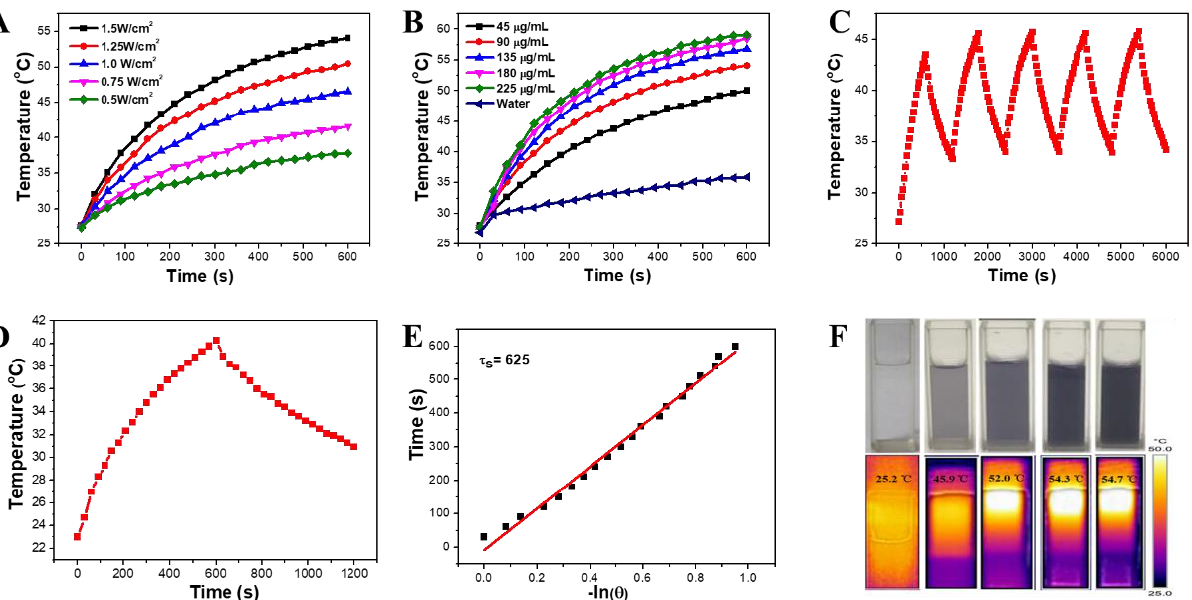
Figure 2. ( A ) Photothermal curves of PTA-NPs (45 µ g/mL) under irradiation of 635 nm laser at different power densities; ( B ) photothermal curves of PTA-NPs at different concentration under 635 nm laser irradiation (1.25 W/cm 2 ); ( C ) photothermal stability of PTA-NPs (45 µ g/mL) during five on/off cycles of laser (1.25 W/cm 2 ); ( D ) photothermal effect of PTA-NPs in water under irradiation of 635 nm laser (1.25 W/cm 2 ) for 10 min, followed by the cooling for 10 min; ( E ) negative logarithmic relationship between cooling time and temperature; ( F ) photothermal images of different concentrations of PTA-NPs under 635 nm laser (1.25 W/cm 2 ) irradiation (top: images of PTA-NP solution under natural light; bottom: thermal images after 635 nm laser irradiation for 10 min).